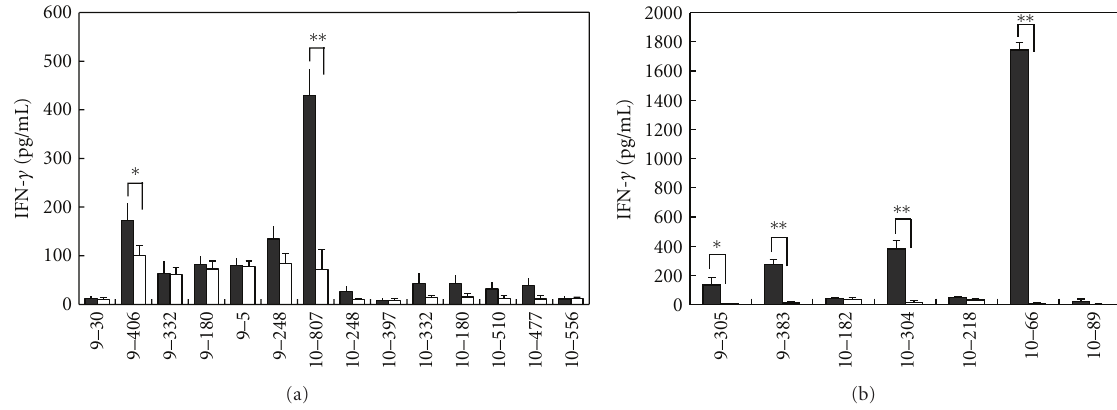
Figure 1: IFN- γ production from CTLs responding to CDH3- or KIF20A-derived peptides. IFN- γ production by CTLs induced with CDH3- derived peptides (a) or KIF20A-derived peptides (b) responding to respective peptide-pulsed HLA-A ∗ 2402 positive TISI cells. CTLs were expanded and harvested following “ in vitro induction of peptide-specific CTL,” and IFN- γ production was examined by IFN- γ ELISA. “Closed bar” indicates the mean IFN- γ production responding to TISI cells pulsed with indicated peptide, and “open bar” indicates the mean IFN- γ production responding to TISI cells pulsed with HIV-A24 peptide (negative control). All experiments were performed triplicate. Similar results were obtained in three to five independent experiments. ∗ P < 0 . 05, ∗∗ P < 0 . 01.